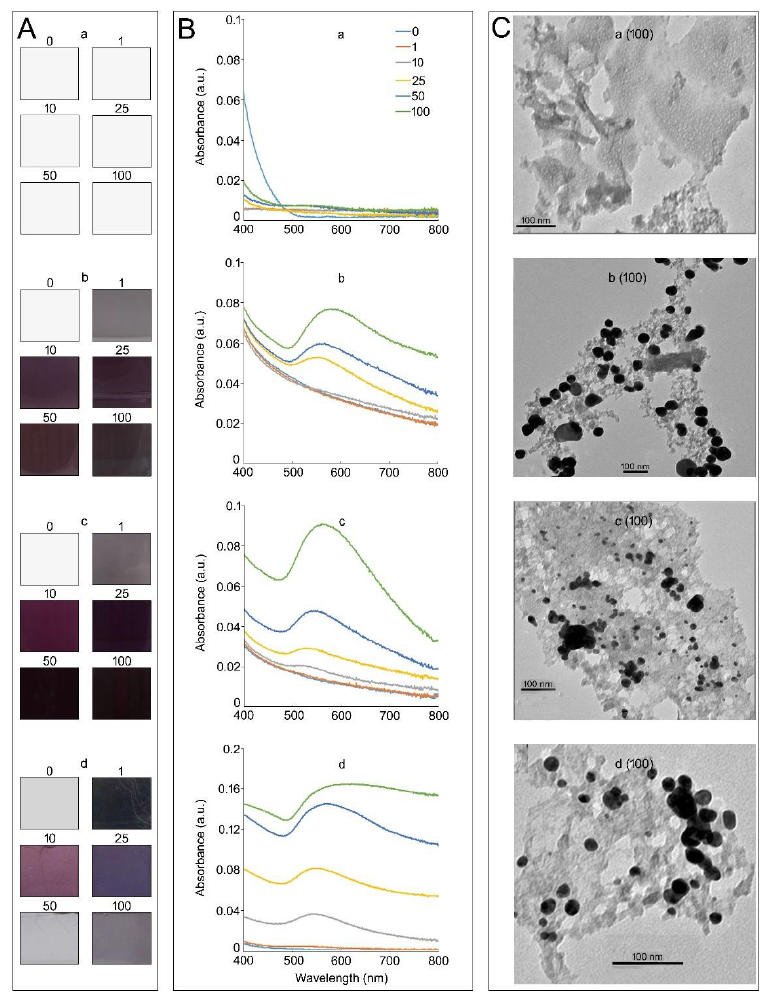
Figure 1. The solution color, UV – Vis spectrum, and TEM images of KAuCl4-mediated synthesis of AuNPs in different media. The effects of ( a ) deionized H2O, ( b ) one-half-strength MS medium, ( c ) NR comprising one-half-strength MS medium supplemented with 1.5% ( w / v ) Suc, and ( d ) wild-type Arabidopsis seedlings grown in NR medium supplemented with 1.5% ( w / v ) Suc and different concentrations (0 – 100 ppm) of KAuCl4 for 14 d on ( A ) color and ( B ) UV – Vis spectrum. A shift from colorless to different shades of bluish to bluish – purple and an increase in the absorbance at 530 nm, corresponding to the plasmon absorbance of AuNPs, suggested its formation in the medium in KAuCl4 concentration-dependent manner. ( C ) TEM images of AuNPs in different media ( a – d ) supplemented with KAuCl4 (100 ppm).